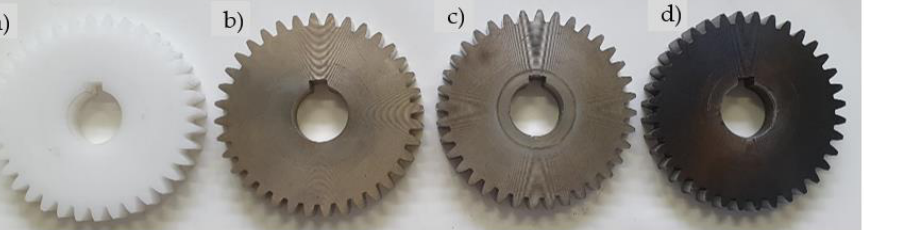
Figure 2. Tested gears made of POM: ( a ) without coating, ( b ) Al-coating, ( c ) Cr-coating, ( d ) CrN- coating. Table 2. Basic parameters of the tested gear pair.